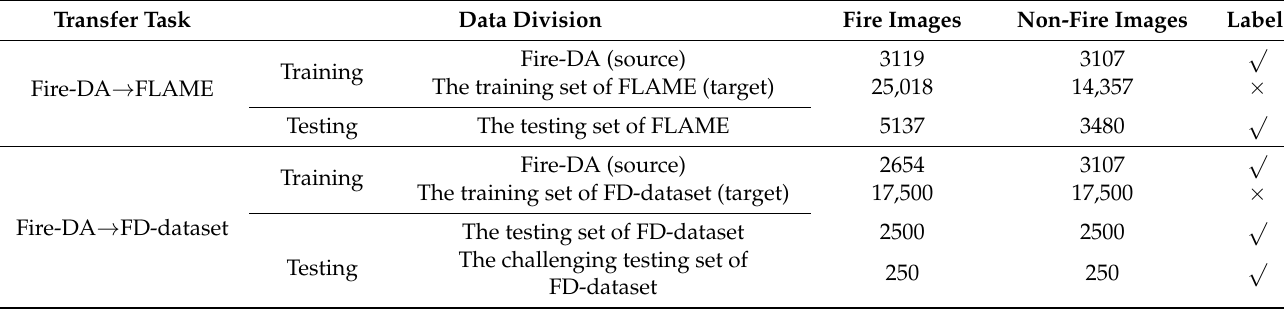
Table 3. The detailed statistics of training and testing sets for